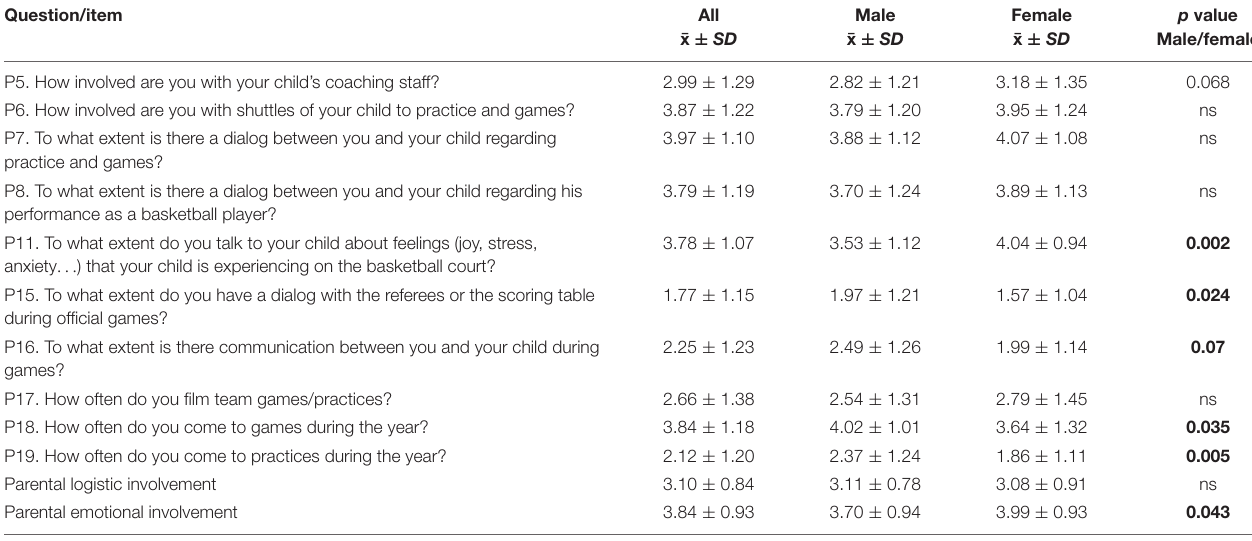
TABLE 1 | Descriptive statistics for parental (P) answers and the significance of comparison between mothers and fathers ( p value). Question/item